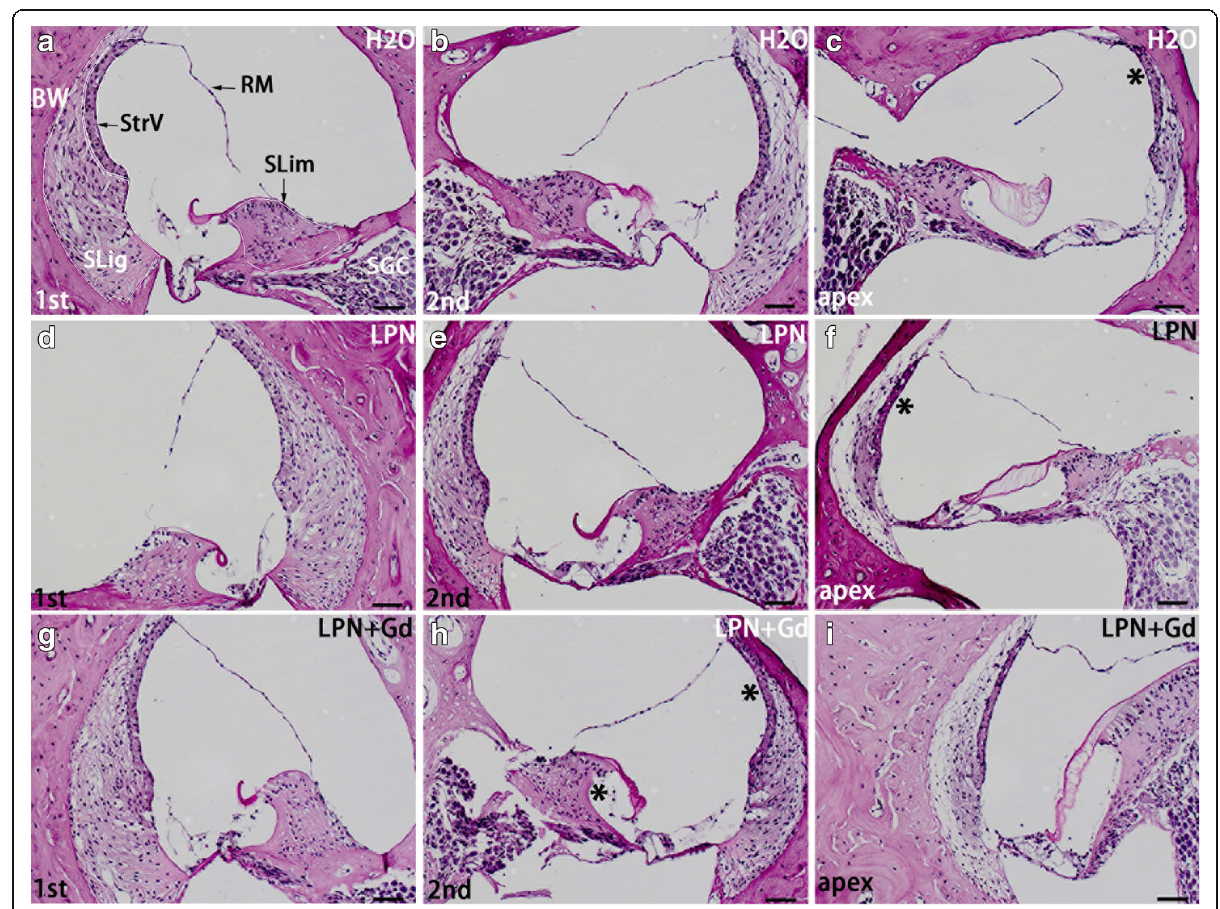
Fig. 5 Glycosaminoglycan secretion in rat cochlea exposed to liposome nanocarriers was detected using periodic acid Schiff ’ s staining light microscopy. The spiral limbus ( SLim ) and bony wall ( BW ) of the cochlea showed the most intensive staining in groups of negative control ( H2O ) ( a – c ), empty liposome nanocarrier (LPN) ( d – f ), and Gd-DOTA-containing LPN ( LPN+Gd ) ( g – i ). The staining area with visibly higher intensities were indicated by * in c , f , and h in comparison to the left column. RM Reissner ’ s membrane, SGC spiral ganglion cell, SLig spiral ligament, StrV stria vascularis, 1st basal turn, 2nd second turn. Scale bar =50 μ